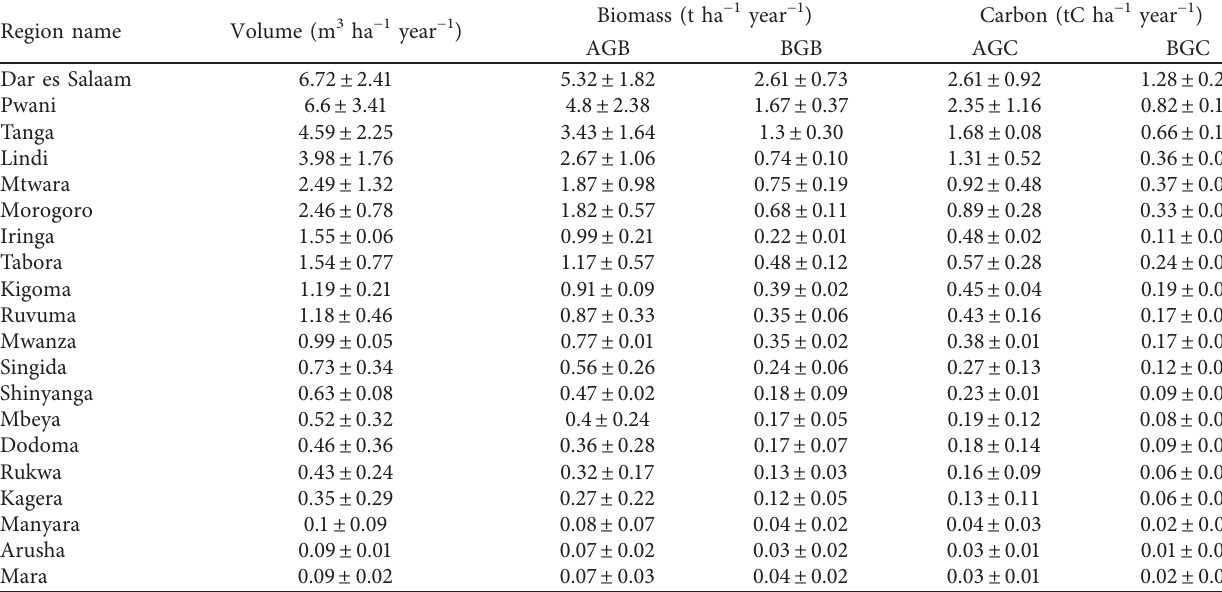
Table 4: Volume, biomass, and carbon removals in Miombo woodlands by regions in Mainland Tanzania.